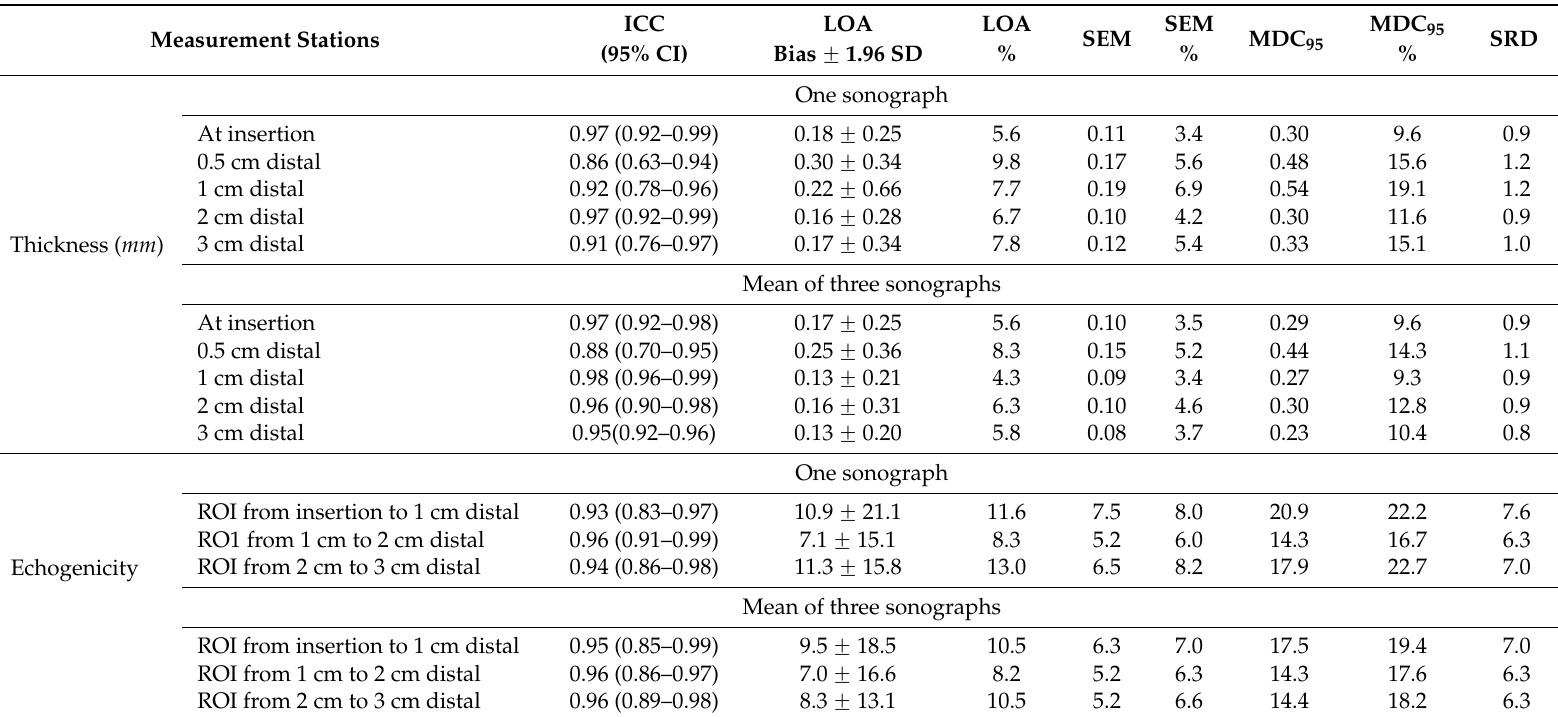
Table 2. Showing ICCs, SEMs, SEMs%, MDC 95 and MDC 95 % for the thickness and echogenicity at all measurement stations using one sonograph and the mean of three sonographs, where ICC = intraclass correlation coefficient; CI = confidence interval; SEM = standard error of measurement, SEM% = relative standard error of measurement; MDC 95 = minimal detectable change at a 95% confidence level; MDC 95 % = relative minimum detectable change at 95% confidence level; SRD = Smallest Real Difference; and LOA = limits of